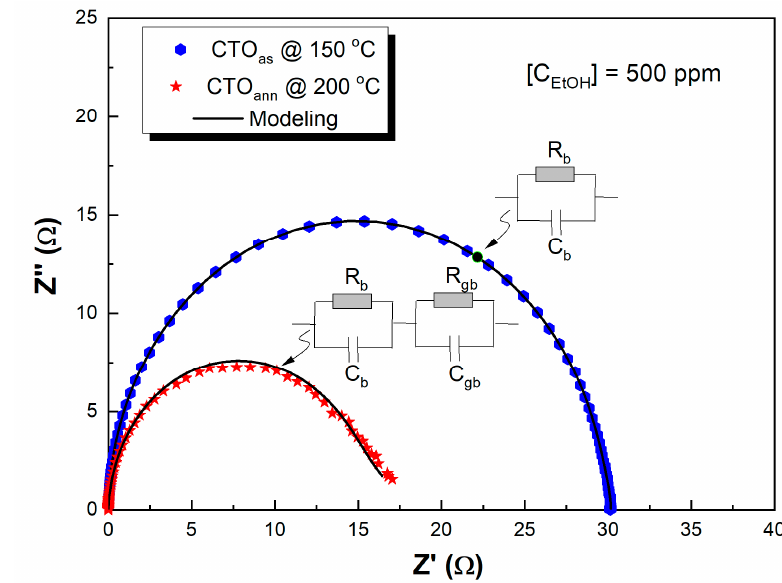
Figure 6. The CTO as and CTO ann AC experimental results and modeling.